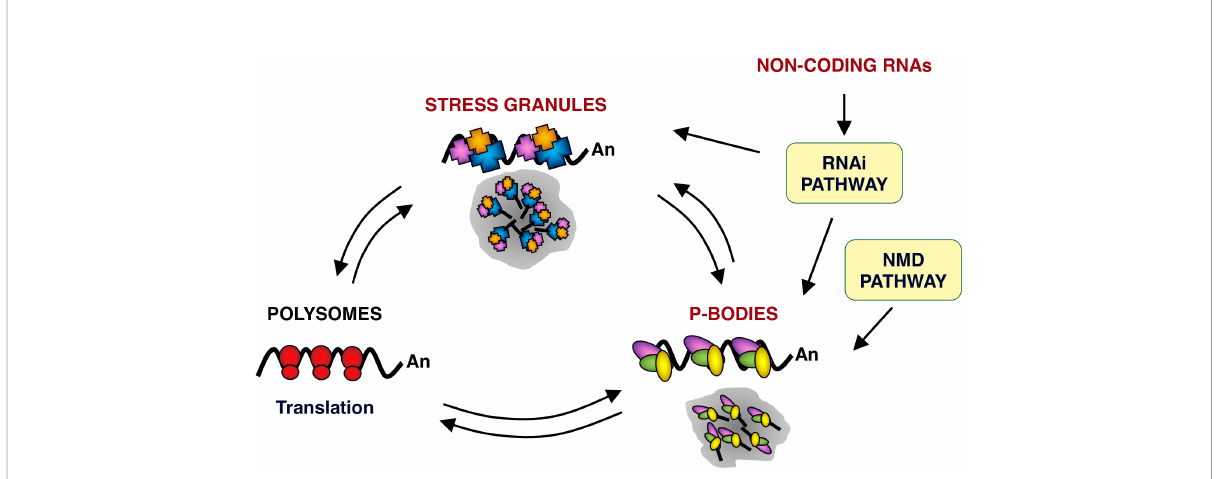
FIGURE 1 mRNA metabolism in eukaryotic cells. Schematic representation of mRNA locations in cells. mRNAs are found in three major RNPs: polysomes, PBs and SGs. PBs and SGs are large dynamic centers of mRNA sorting, storage and degradation. RNPs from and to polysomes and from and to SGs and PBs are in a dynamic equilibrium. Within PBs, RNPs could undergo further remodeling and de fi ne a path to follow, including their return to polysomes. In addition, PBs have been shown to interact and exchange components with SGs. PBs are also related to mRNA quality control mechanisms, such as NMD pathway. In silencing, non-coding RNAs function as the guide molecules that are incorporated into RNA- induced silencing complex (RISC) to control the translation and degradation of their target mRNAs within PBs and SGs. Arrows indicate the different equilibrium between RNPs. Ribosomes (red ovals), SG protein components (blue, orange and purple polygons) and PB protein components (yellow, green and purple ovals) are also